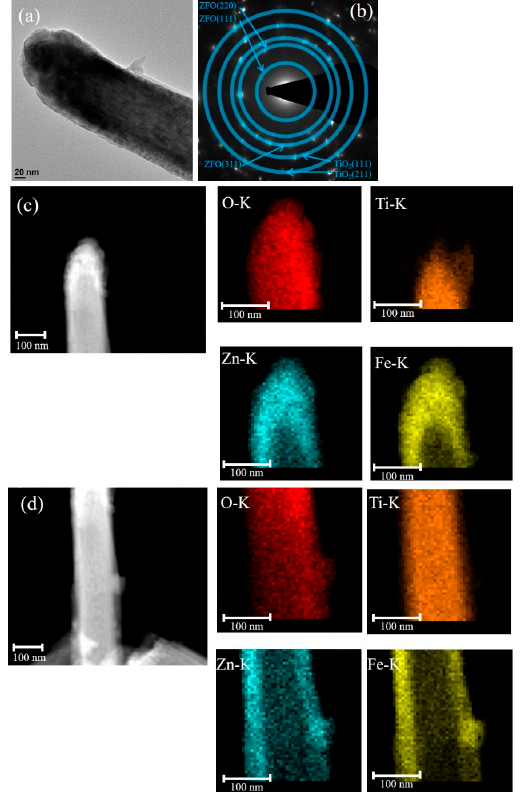
Figure 4. Analyses of TiO 2 –ZFO-3 nanorods: ( a ) low-magnification TEM image of the single nanorod; ( b ) SAED pattern; ( c ) Zn, Fe, Ti, and O mapping micrographs in the head region of the nanorod; ( d ) Zn, Fe, Ti, and O mapping micrographs in the lateral region of the nanorod.